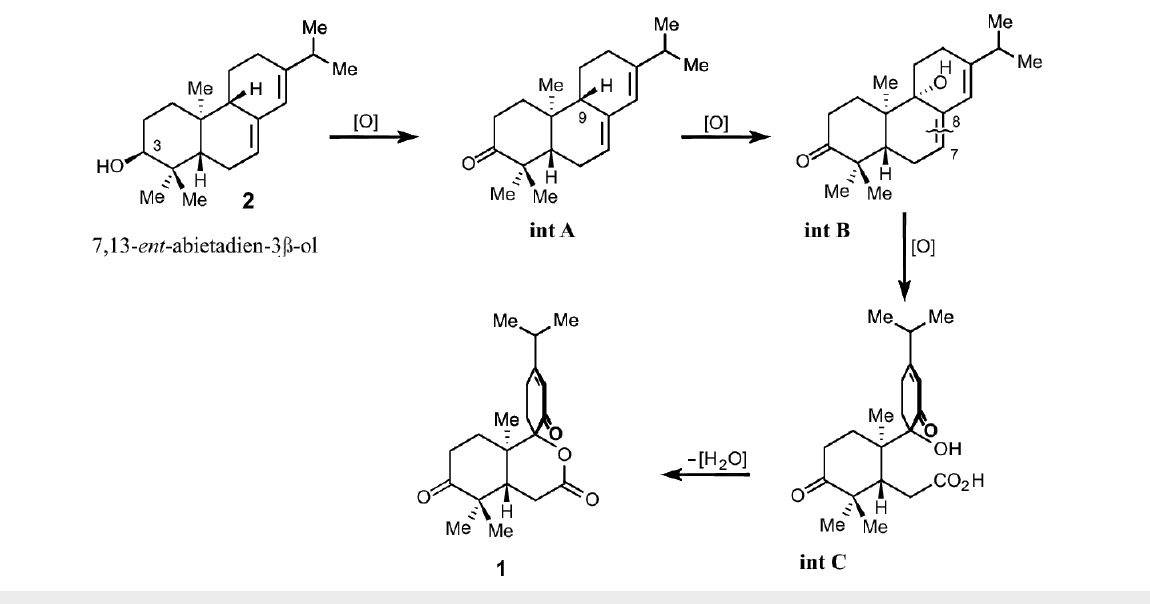
Scheme 1: Proposed biosynthetic pathway for decandrinin ( 1